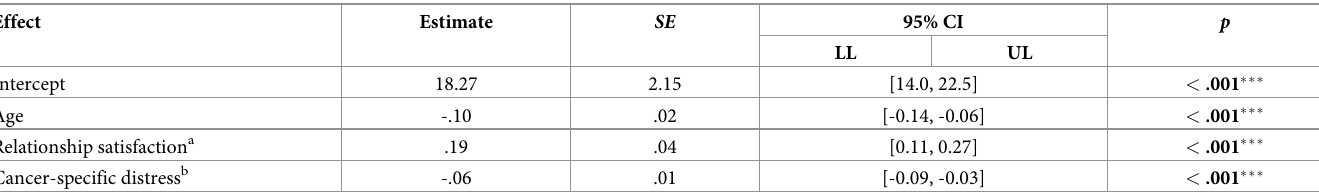
Table 4. Results of the stepwise regression analysis for partner-acceptance in men ( n =